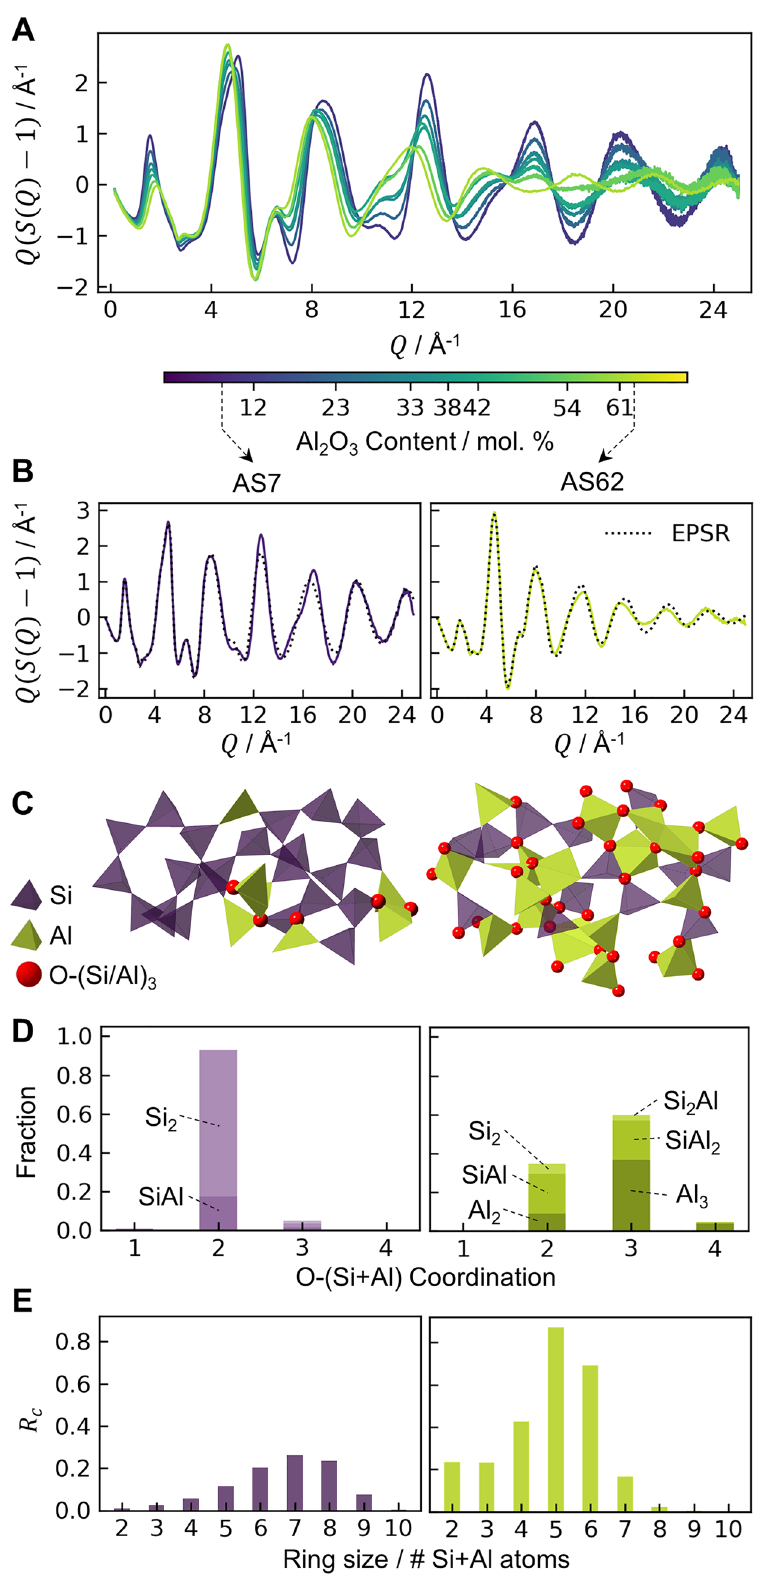
Figure 4. Structure of the endmembers in phase-separated mullite and aluminosilicate glasses. ( A ) X-ray diffraction interference functions of phase-separated glasses, with compositions ranging AS12-AS61. ( B ) Interference functions for the endmember compositions, AS7 and AS62, linearly extrapolated from the glasses in (A). EPSR provides structural models of the endmembers consistent with the experimental data: ( C ) structure visualizations, ( D ) oxygen coordination environments, and ( E ) ring size distributions of AS7 and AS62 endmembers. R c is the number of -O-(Si/Al)- rings normalized by the number of atoms in the simulation